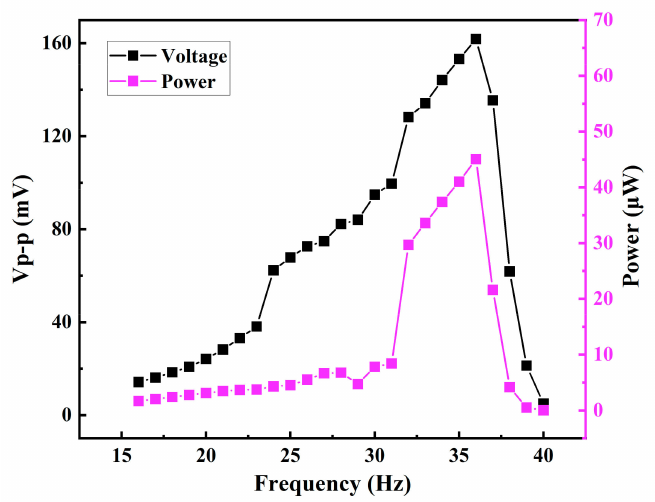
Figure 2. Simulated harvesting performance: peak-to-peak voltage and averaged power output in terms of